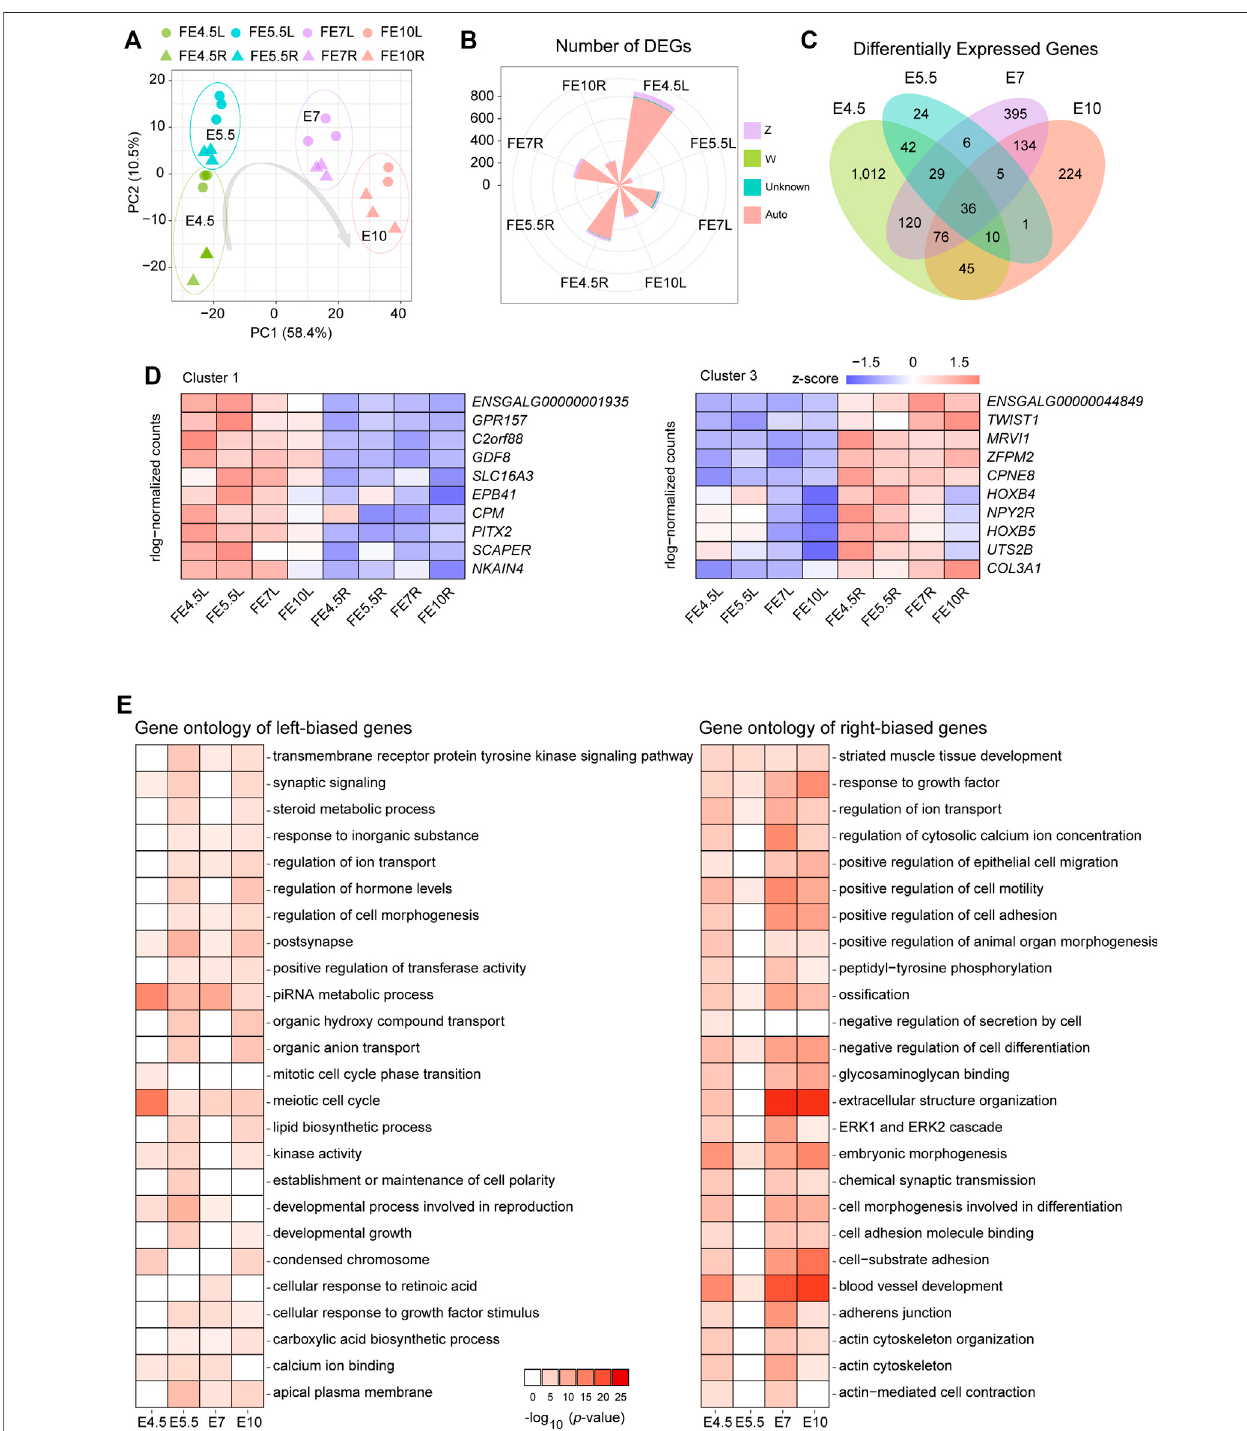
FIGURE 2 | Analysis of RNA-seq data from the left and right gonads. (A) PCA plot of RNA-seq data of left and right gonads at different developmental stages; (B) The number of DEGs and chromosomal allocation in the left and right gonads; (C) Venn diagrams show the shared and unique DEGs obtained from each pairwise comparison between the left and right gonads, including four groups: left gonads and right gonads of female embryonic day 4.5(FE4.5L vs FE4.5R), FE5.5L vs . FE5.5R, FE7L vs . FE7R, and FE10L vs . FE10R); (D) The gene expression patterns of cluster 1 (left) and cluster 3 (right); (E) Top 25 signi fi cantly enriched terms of genes among the LBGs (left) and RBGs (right). The depth of the colors represents the size of the p -value.